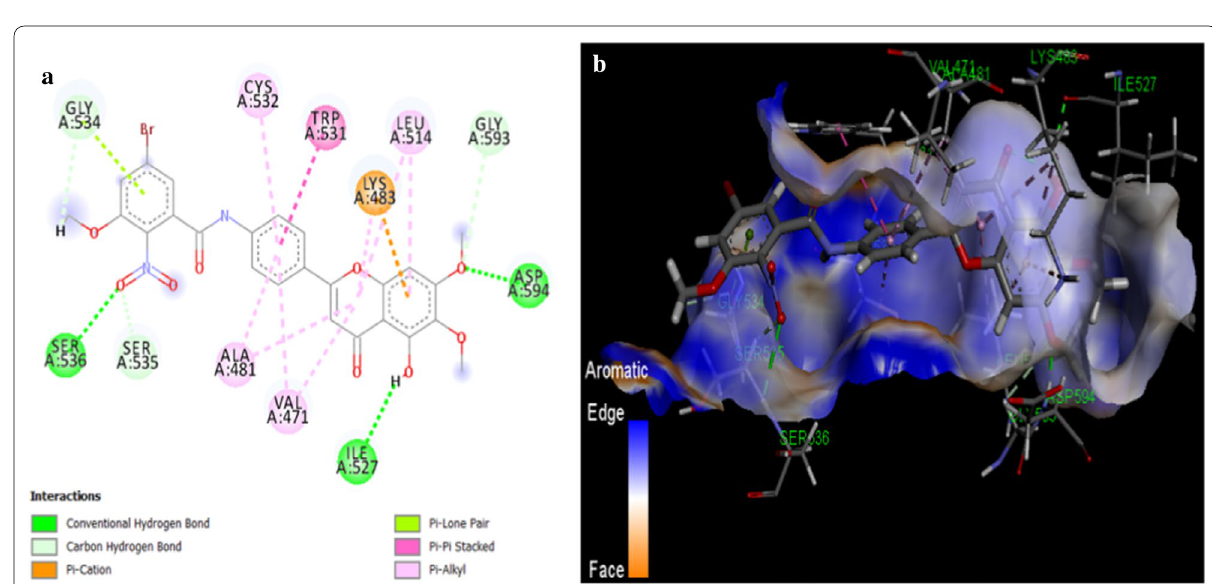
Fig. 4 a 2D diagram for the interaction of compound N2 with V600E-BRAF, b 3D view of the compound N2 in the binding site of